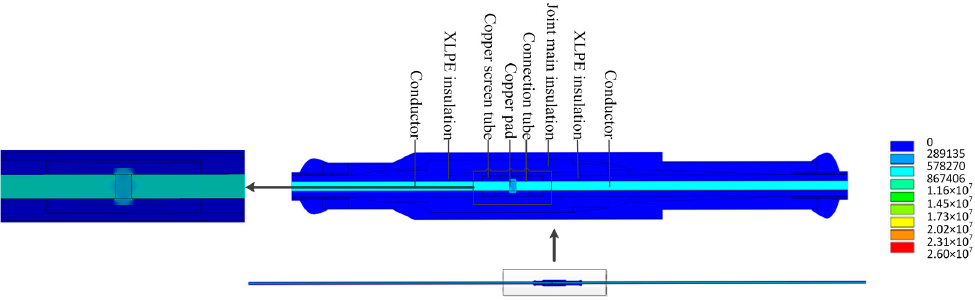
Figure 2. Current density distribution of the cable joint.